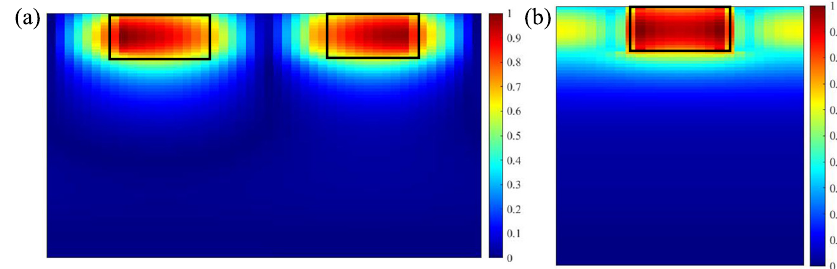
Figure 4. Normalized electric field distribution at 1541.16 nm for ( a ) XZ and ( b )